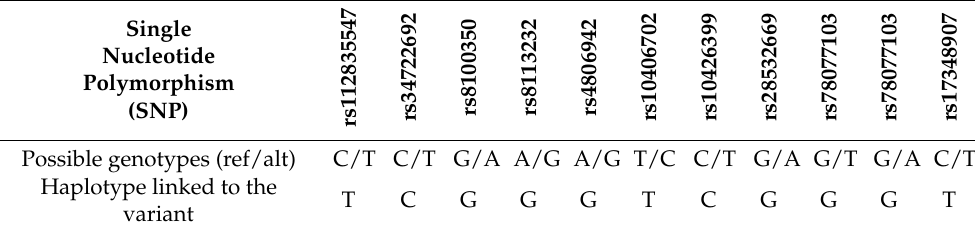
Table 3. Haplotype linked to the c.245A>G variant in GIPC3